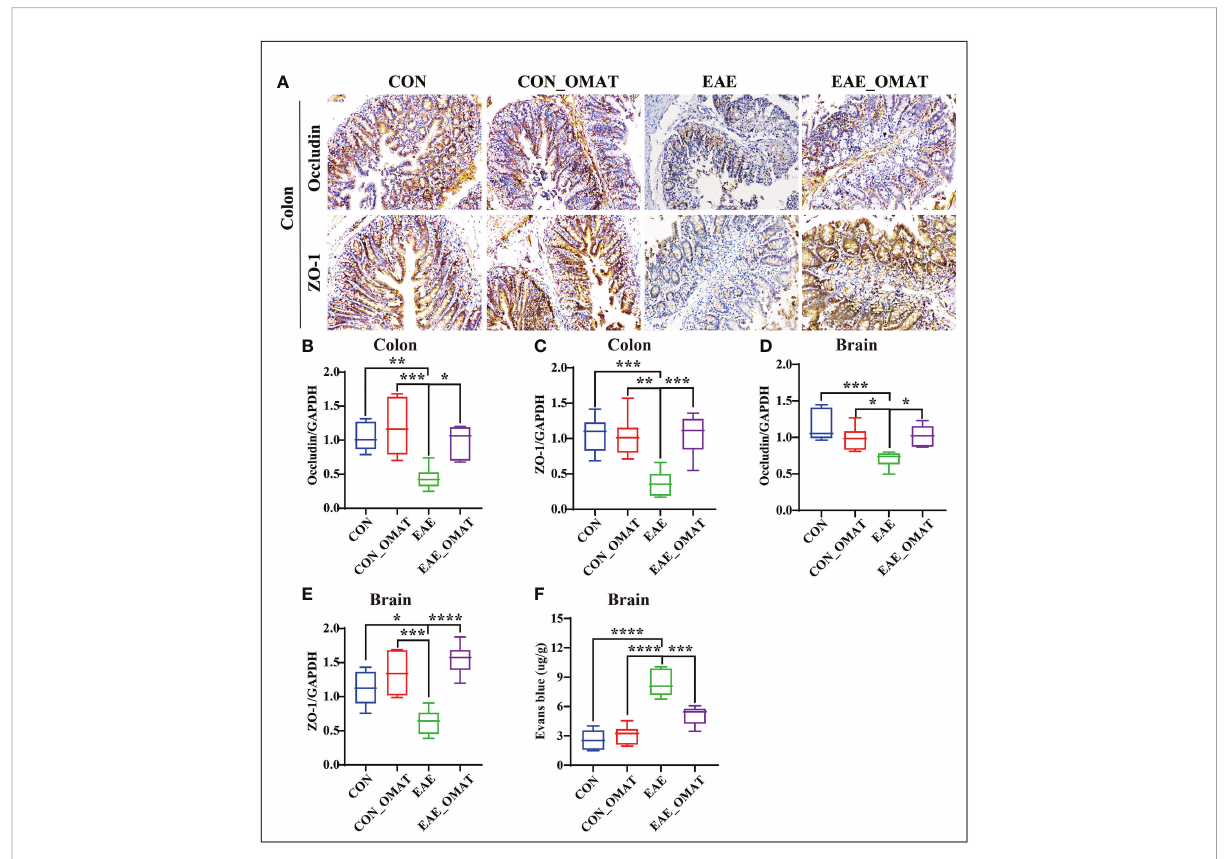
FIGURE 9 Effect of oxymatrine on the integrity of the blood-brain barrier and intestinal epithelial barrier in EAE mice. (A) Representative images of the hippocampus and colon tissue structure were detected by immunohistochemistry staining (n = 6 in each group). Original magni fi cation 20X. (B, C) mRNA levels of occludin in the hippocampus (B) and colon (C) . (D, E) mRNA levels of ZO-1 in the hippocampus (D) and colon (E) . (F) Quantitative analysis of Evans blue extravasation in the brain of EAE mice (n = 3 in each group). All data were expressed as the mean ± SD and statistical differences are represented by *, P < 0.05, **, P < 0.01, ***, P < 0.001, and ****, P < 0.0001 based on the LSD-t